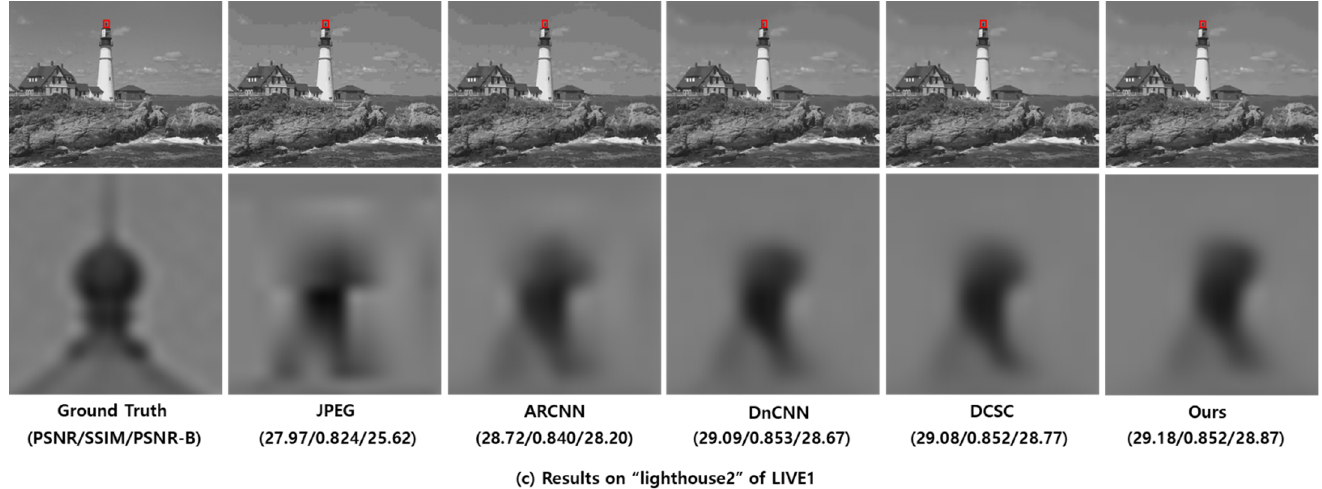
Figure 10. Visual comparisons on a JPEG compressed images where the figures of the second row represent the zoom-in for the area represented by the red box.